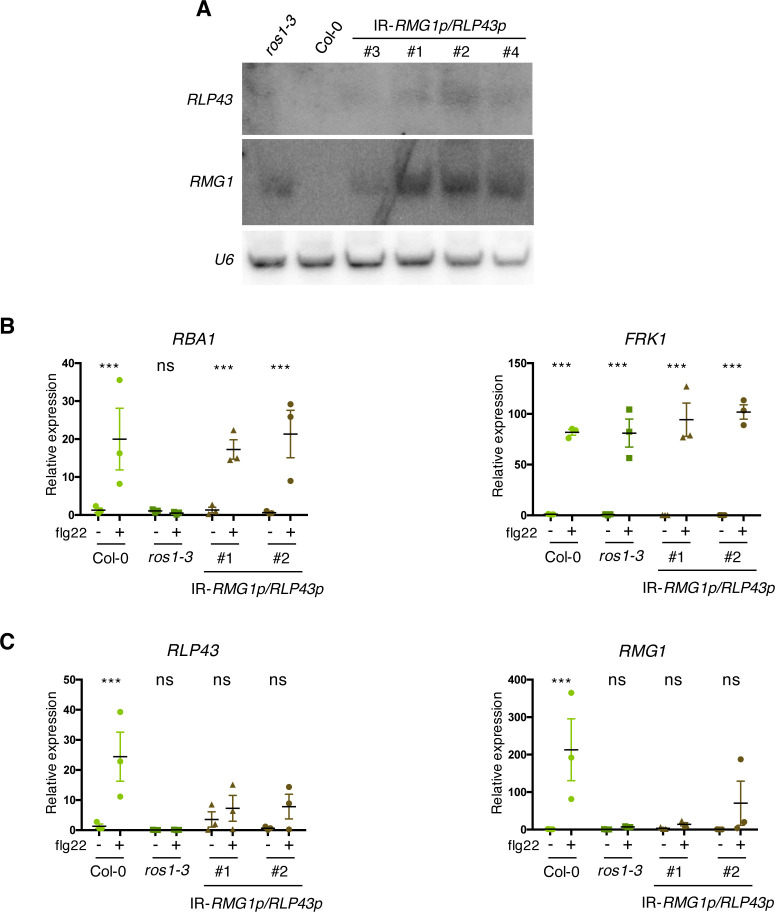
Artificial siRNA-directed remethylation of RMG1 and RLP43 promoters in the Col-0 background limits flg22-triggered induction of these genes.(A) Accumulation of siRNAs at RLP43 and RMG1 promoters in IR-RMG1p/RLP43p lines was detected by low molecular weight northern blot analysis. U6 was used as a loading control. (B) Result from another independent experiment showing gene expression of RBA1 and FRK1 upon 6 hr of mock or flg22 treatments. RT-qPCR analyses of mRNAs from these genes were performed in Col-0, ros1-3, and the two IR-RMG1p/RLP43p independent transgenic lines treated with either mock (water) or 1 μM of flg22 for 6 hr. The mRNA levels are relative to the level of UBQ transcripts. Statistical significance of flg22 treatment on expression was assessed using a two-way ANOVA test and a Sidak’s multiple comparisons test. Asterisks indicate statistical significance (*: p<0.05, **: p<0.01, ***: p<0.001, ns: not significant). (C) Result from another independent experiment showing gene expression of RLP43 and RMG1 upon 6 hr of mock or flg22 treatments. RT-qPCR analyses of mRNAs from these genes were performed in Col-0, ros1-3, and the two IR-RMG1p/RLP43p independent transgenic lines treated with either mock (water) or 1 μM of flg22 for 6 hr. The mRNA levels are relative to the level of UBQ transcripts. Statistical significance of flg22 treatment on expression was assessed using a two-way ANOVA test and a Sidak’s multiple comparisons test. Asterisks indicate statistical significance (*: p<0.05, **: p<0.01, ***: p<0.001, ns: not significant).Figure 6—figure supplement 1—source data 1.Original qRT-PCR data for Figure 6—figure supplement 1.